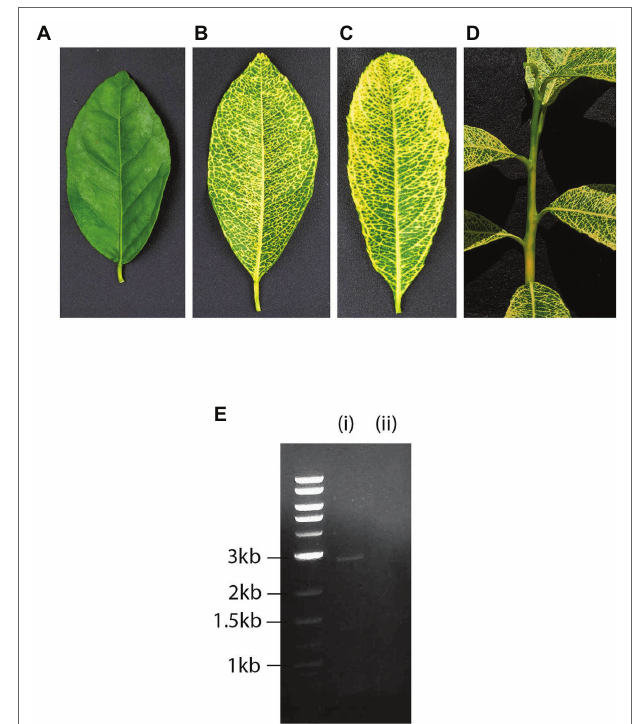
FIGURE 1 | Healthy (A) and yellow-vein infected leaf of citrus indicator Mexican lime Citrus aurantifolia (Christm.) Swingle (B) . Yellow-vein infected leaf (C) and stem (D) of citrus indicator “Etrog” citron ( C. medica L.). Agarose gel electrophoresis of double-stranded RNAs (dsRNAs) extracted from (i) “Etrog” citron graft-inoculated with yellow-vein isolate YV-920C, expressing yellow vein symptoms and (ii) healthy control (E) . Size markers are shown to the left of the